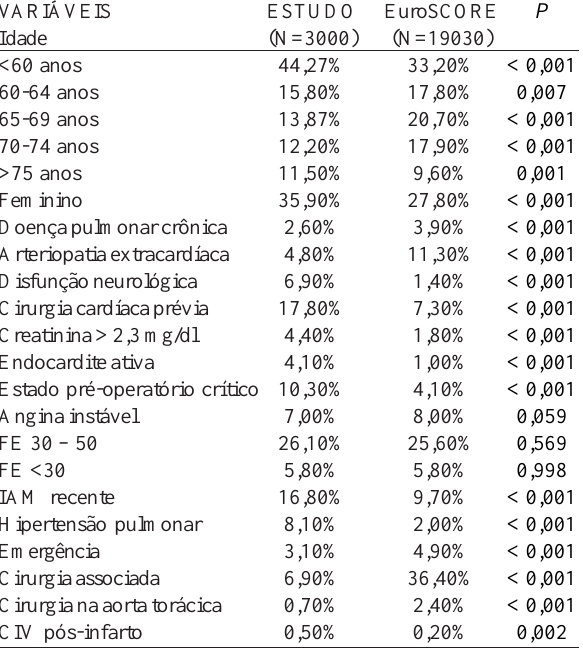
Tabela 1. Prevalência dos fatores de risco no grupo estudo, comparado aos fatores de risco da população do EuroSCORE.